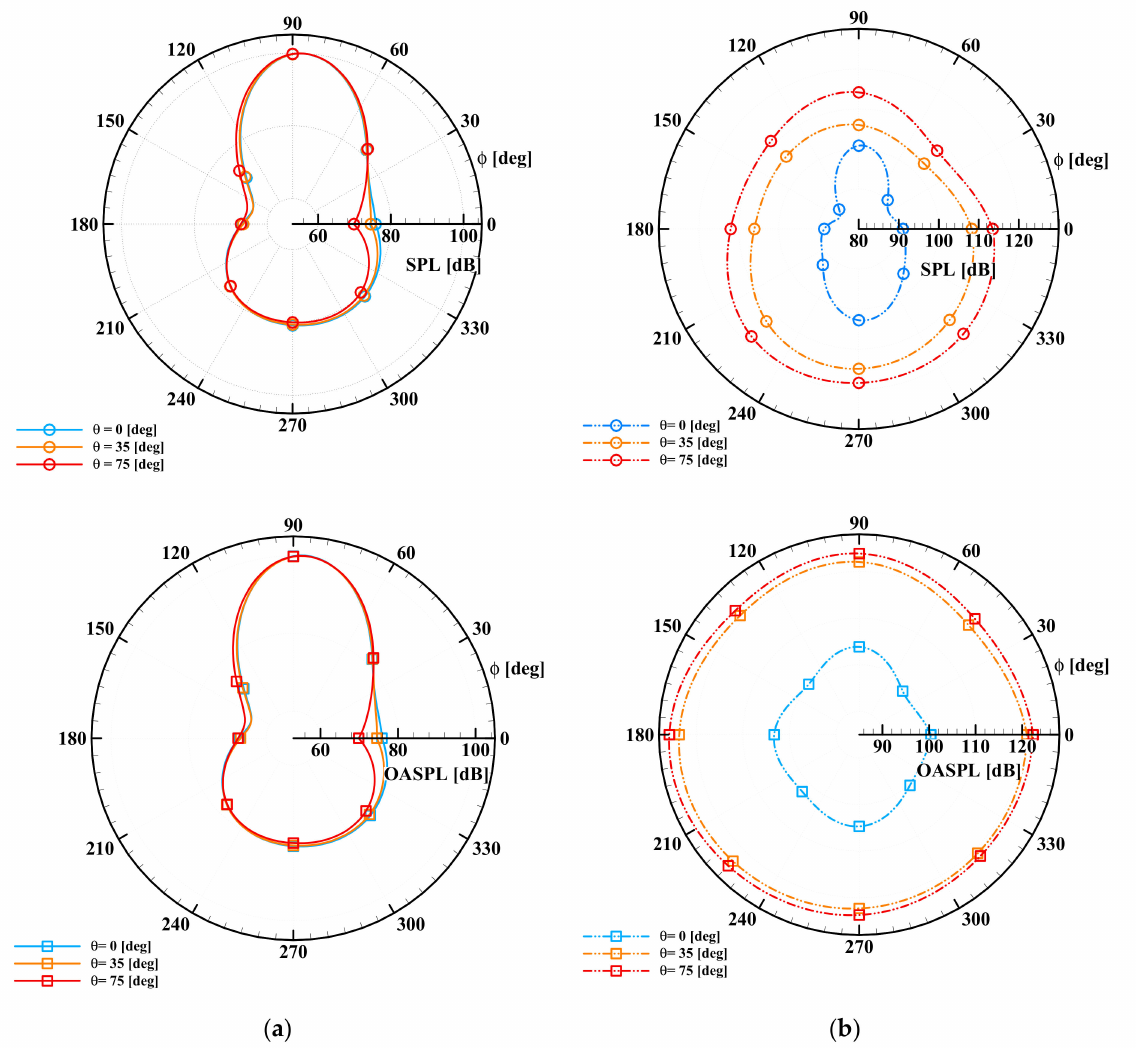
Figure 9. Directivity of SPL at BPF ( top ) and OASPL ( bottom ) at three different θ : ( a ) isolated Propeller; ( b )